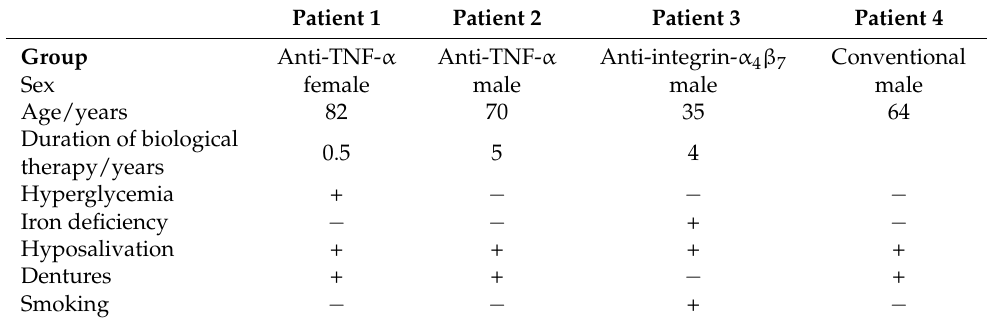
Table A1. Predisposing factors, demographic and therapy data in participants with